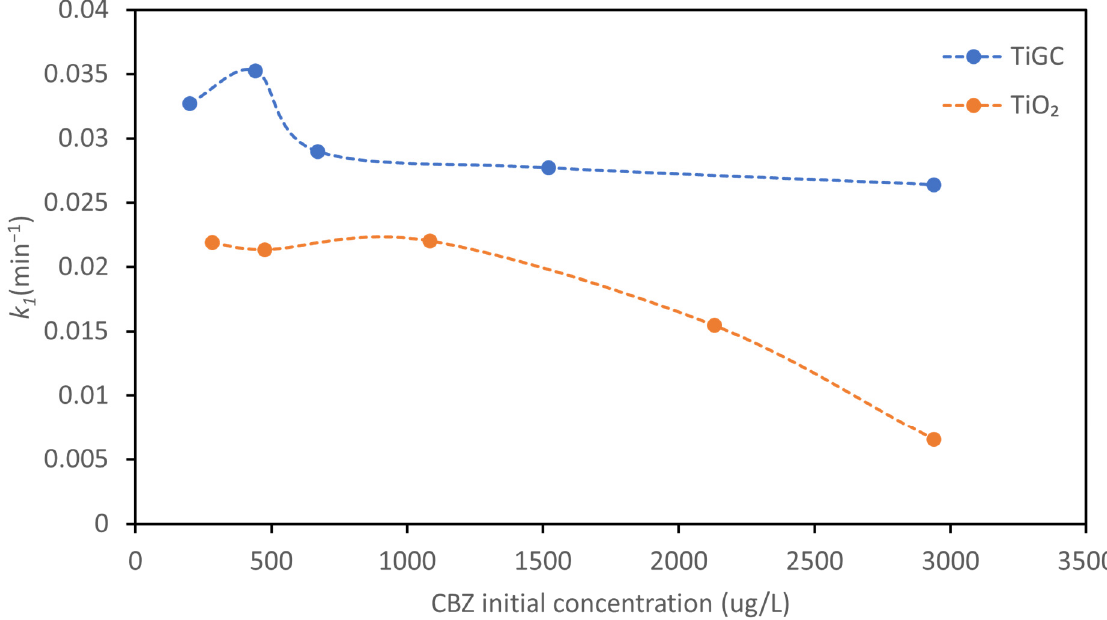
Figure 6. Pseudo first-order reaction constant k 1 of CBZ photodegradation under different CBZ initial concentrations. Catalyst dose TiO 2 and TiGC (TiO 2 :GO ratio 2:1) = 0.2 mg/mL. 1000 W Xe lamp supplied light.